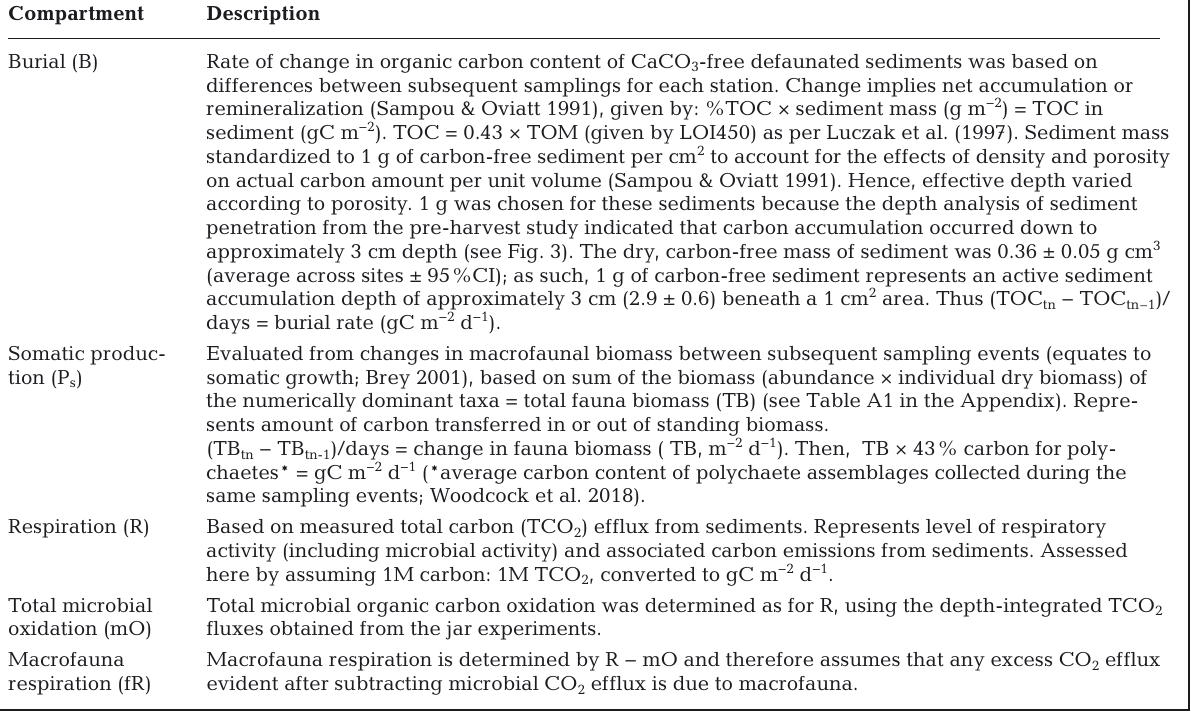
Table 1. Definitions and methods used to convert accumulation and consumption compartments into standard carbon flux units. TOC: total organic carbon, TOM: total organic matter, LOI450: weight loss after ignition at 450°C, tn: sampling